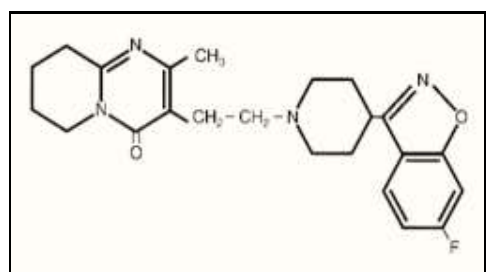
Figure 1. Chemical structure of risperidone